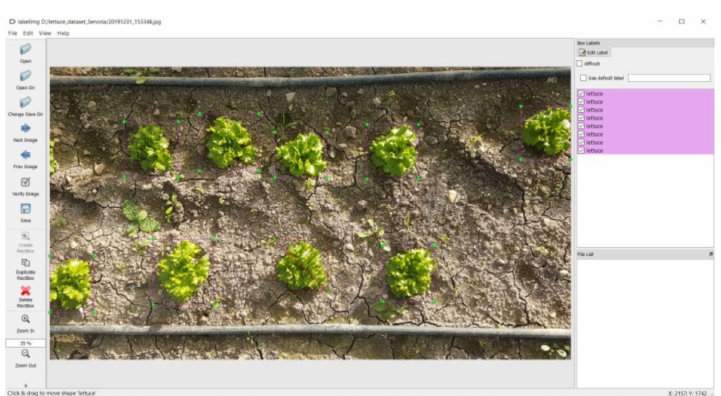
Figure 13. LabelImg tool and lettuce plant